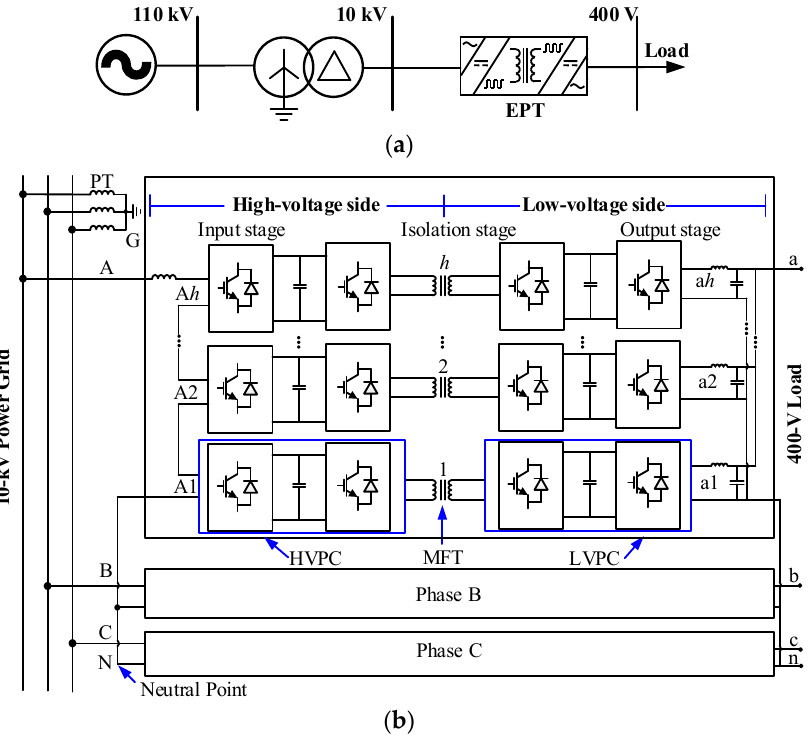
Figure 1. Schematic diagram of ( a ) an Electronic power transformer (EPT)-based distribution system; and ( b ) a 10 kV/400 V cascaded H-bridge EPT (CHB-EPT).